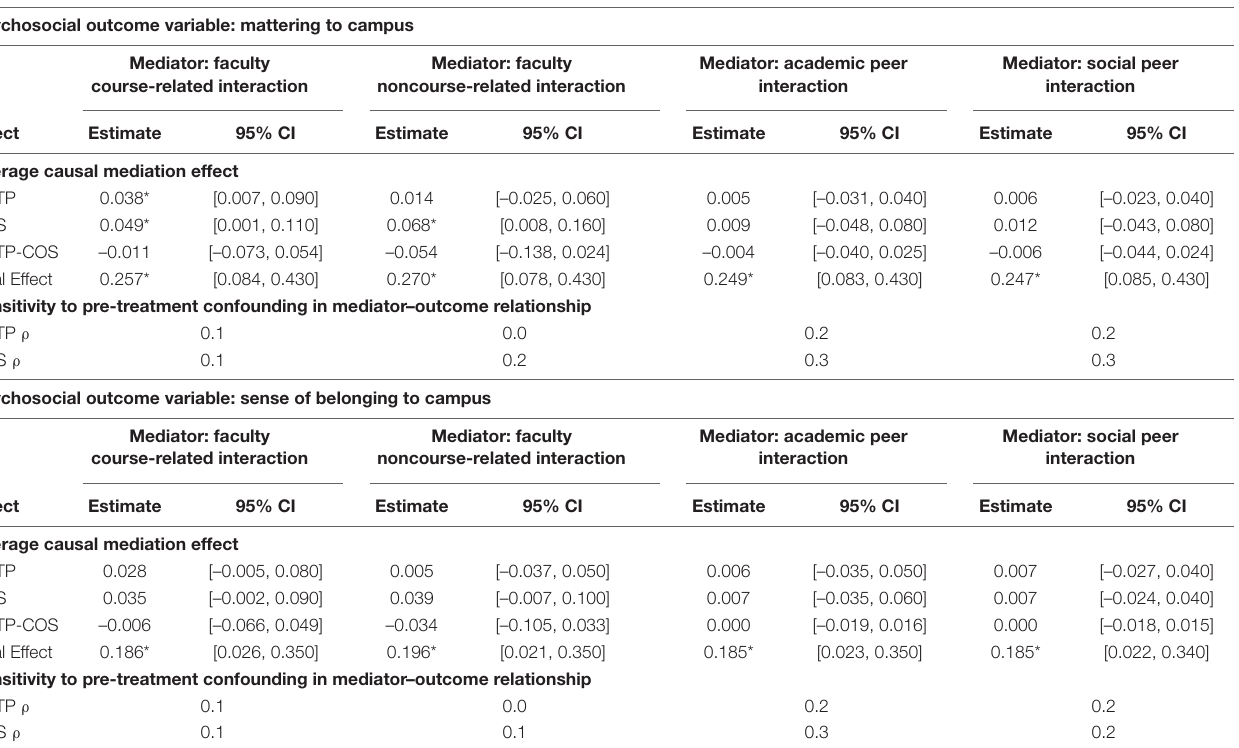
TABLE 4 | Mediation effect estimates assuming independence among mediators.